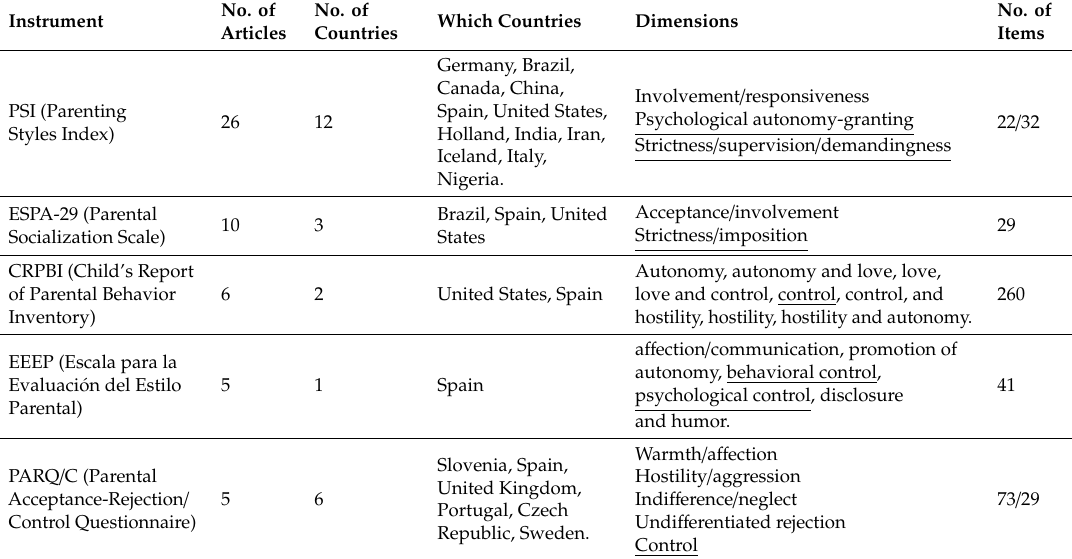
Table 2. Instruments more frequently used in the analyzed